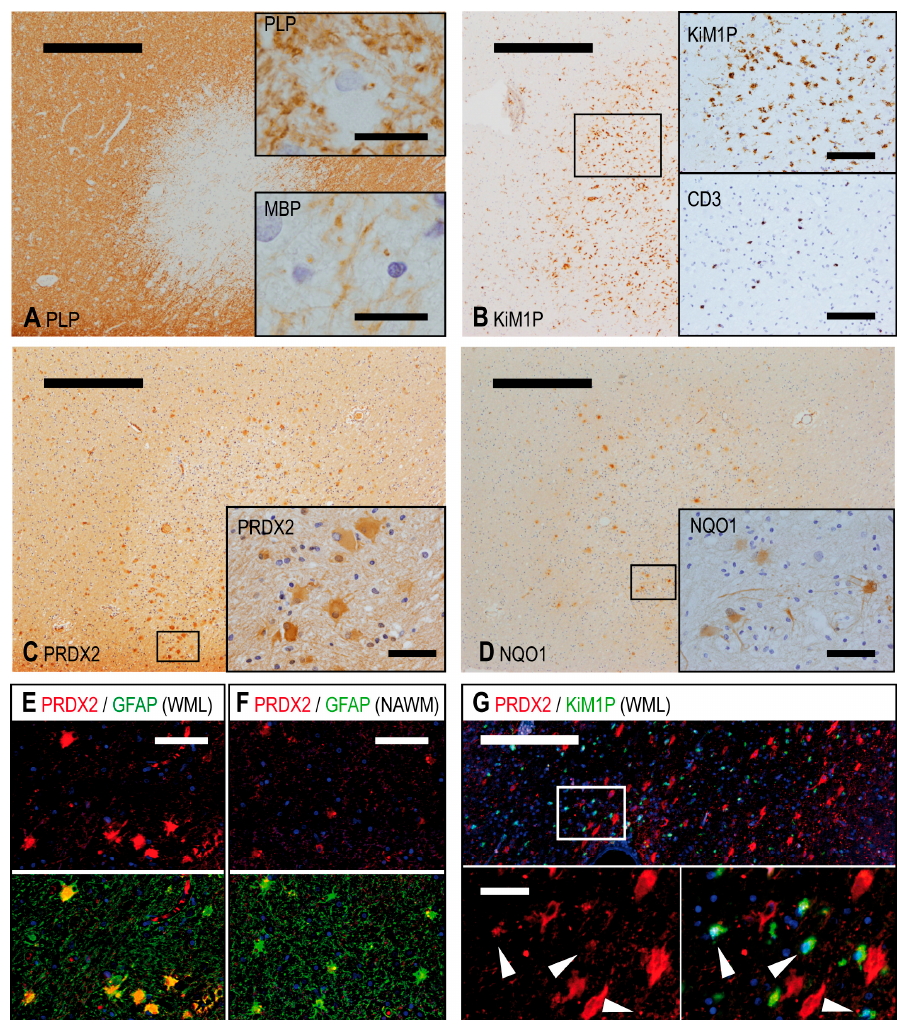
Figure 1. Chronic active white matter lesion (WML) with abundant astrocytic expression of PRDX2. Demyelination was detected by PLP immunohistochemistry ( A ). A few macrophages at the lesion edge contained myelin degradation products, which stained positive for MBP ( A , Insert) and PLP ( A , Insert). Microglia/macrophages were identified by immunohistochemical staining for KiM1P/CD68 ( B ) and T cells for CD3 ( B , Insert). A high expression of PRDX2 ( C ) and NQO1 ( D ) was seen in the same lesion. Double immunofluorescence staining with GFAP confirmed that PRDX2 was mainly expressed by astrocytes ( E , further pictures are provided in the Figure S1). Immunofluorescence staining of an additional white matter lesion exhibited a weak expression of PRDX2 ( G , arrows) in KiM1P-positive macrophages. Scale bars: A – D : 500 µm, A Inserts: 20 µm, B Inserts: 100 µm, C – D Inserts: 50 µm, E – F : 30 µm, G : 200 µm, G Inserts: 30 µm.